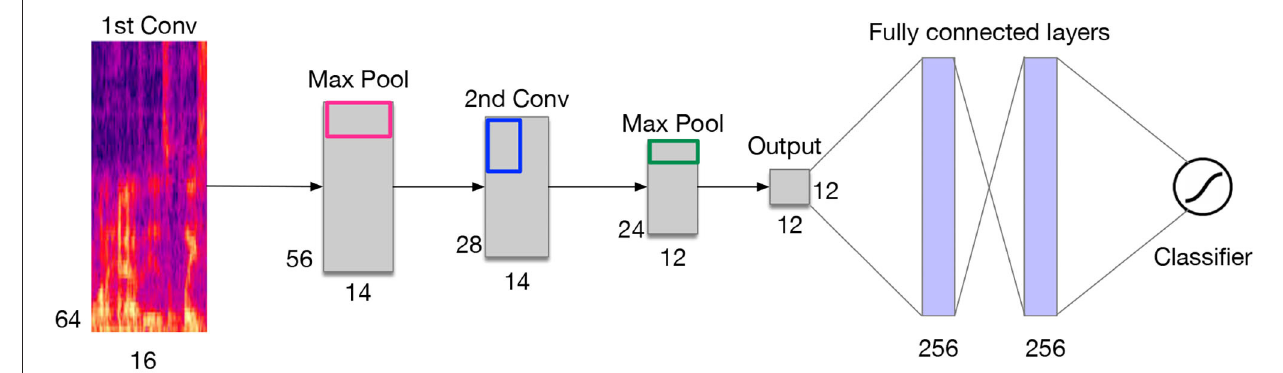
FIGURE 9 | Example of a CNN architecture for a cough sound